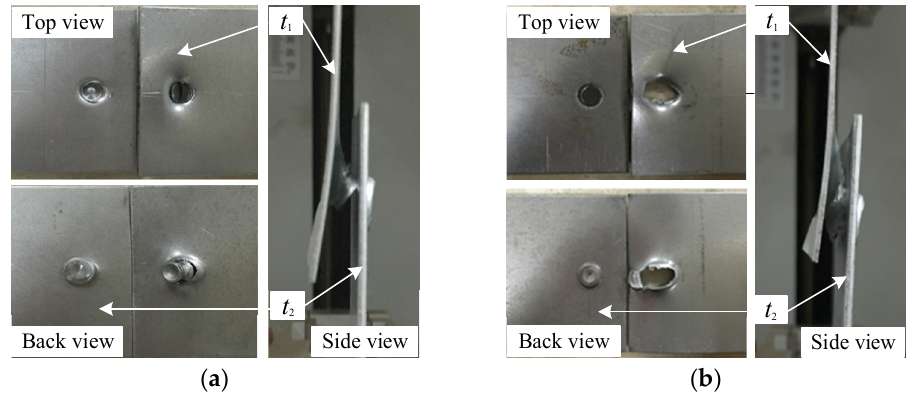
Figure 5. Failure modes of specimens: ( a ) failure mode I, ( b ) failure mode II. Table 2. Mechanical parameters of the CFS-SPR connection. Specimen Number